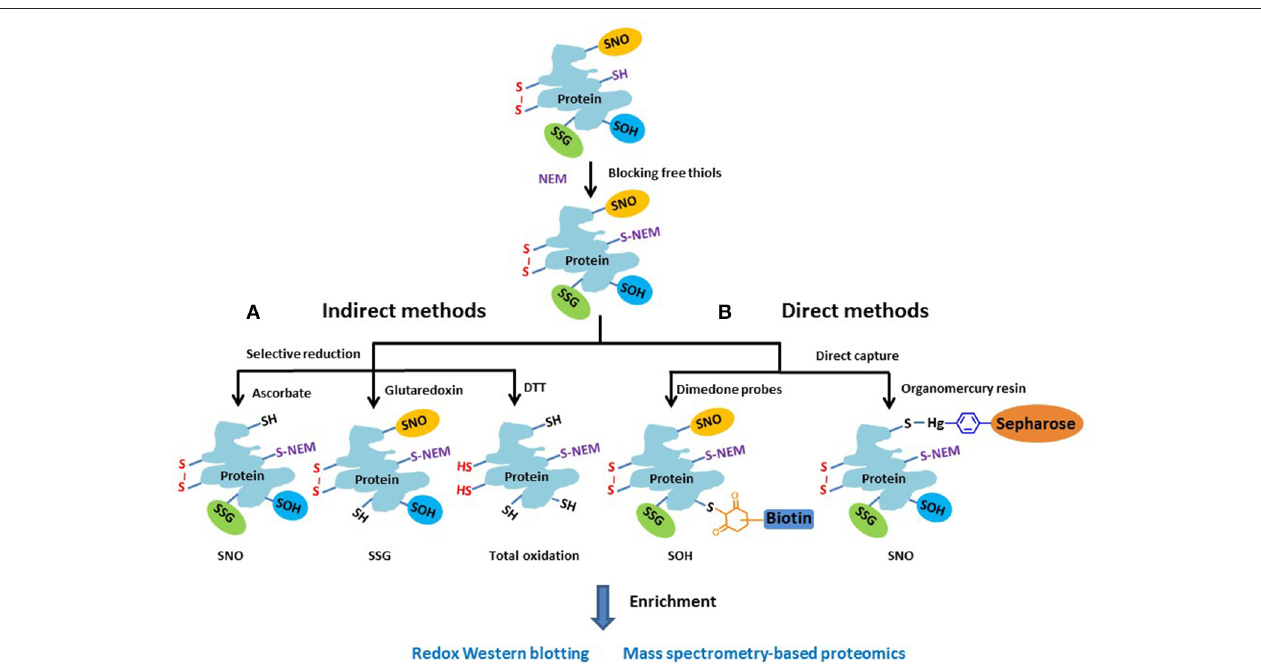
FIGURE 3 | Schematic of the general approaches for measuring different reversible thiol-based redox PTMs. The free thiols are typically blocked by alkylation with NEM as the initial step. (A) In the indirect methods, the different types of modified cysteines are selectively reduced to free thiols by using individual sets of reagents. (B) In the direct methods, dimendone probe is often used to react with SOH, and organomercury resin for SNO. The reduced or labeled protein samples are then subjected to enrichment and measurement by either gel-based or MS-based proteomic